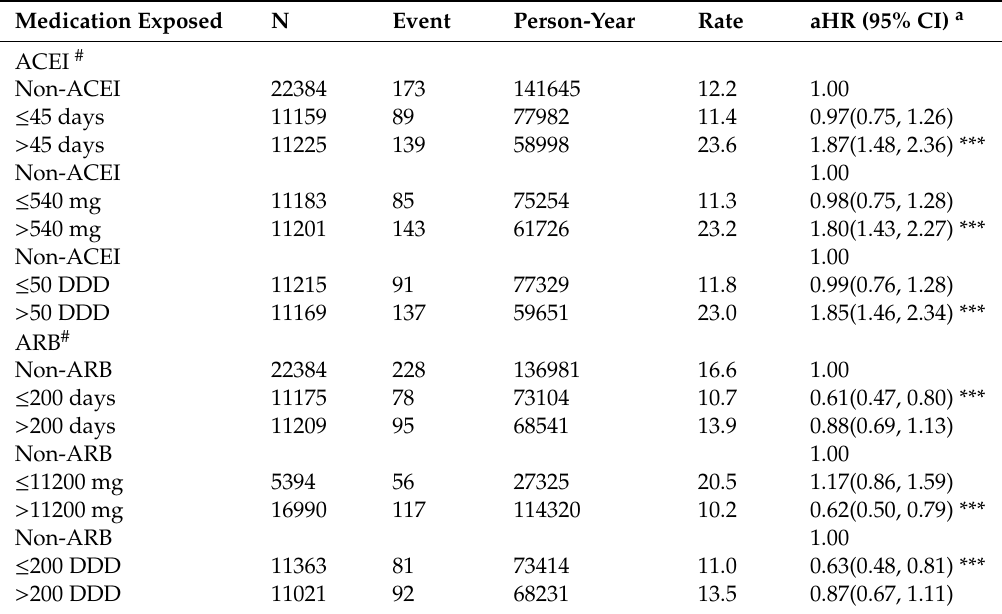
Table 3. Incidence and adjusted hazard ratios of lung cancer stratified by average days used per year, average dose per year and average DDD (defined daily dosages) per year of angiotensin-converting enzyme inhibitor (ACEI) or angiotensin receptor blocker (ARB)